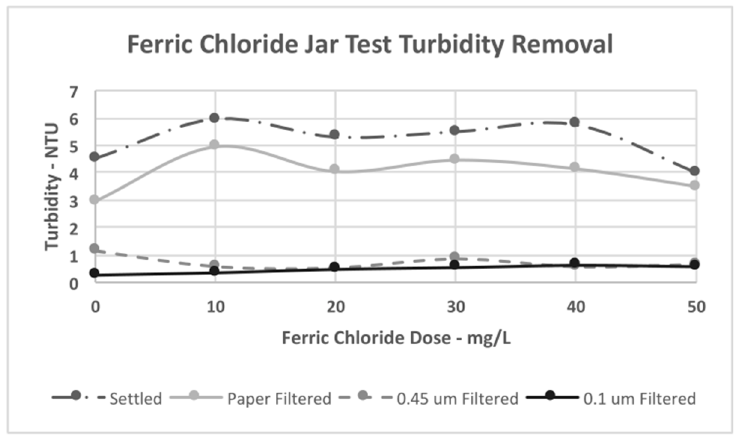
Figure 3. Turbidity after settling versus ferric dose and filtering through 8 μ m filter paper, a 0.45 μ m membrane filter, and a 0.1 μ m membrane filter.